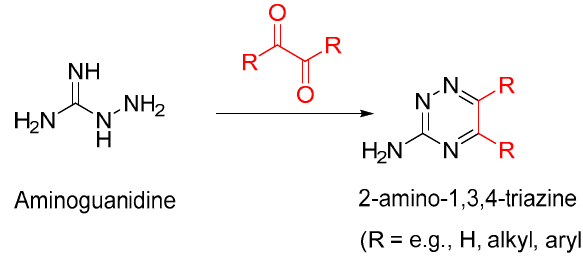
Figure 9. Sequestration of the reactive 1,2-dicarbonyl compounds, the early Maillard reaction inter- mediates, by aminoguanidine.